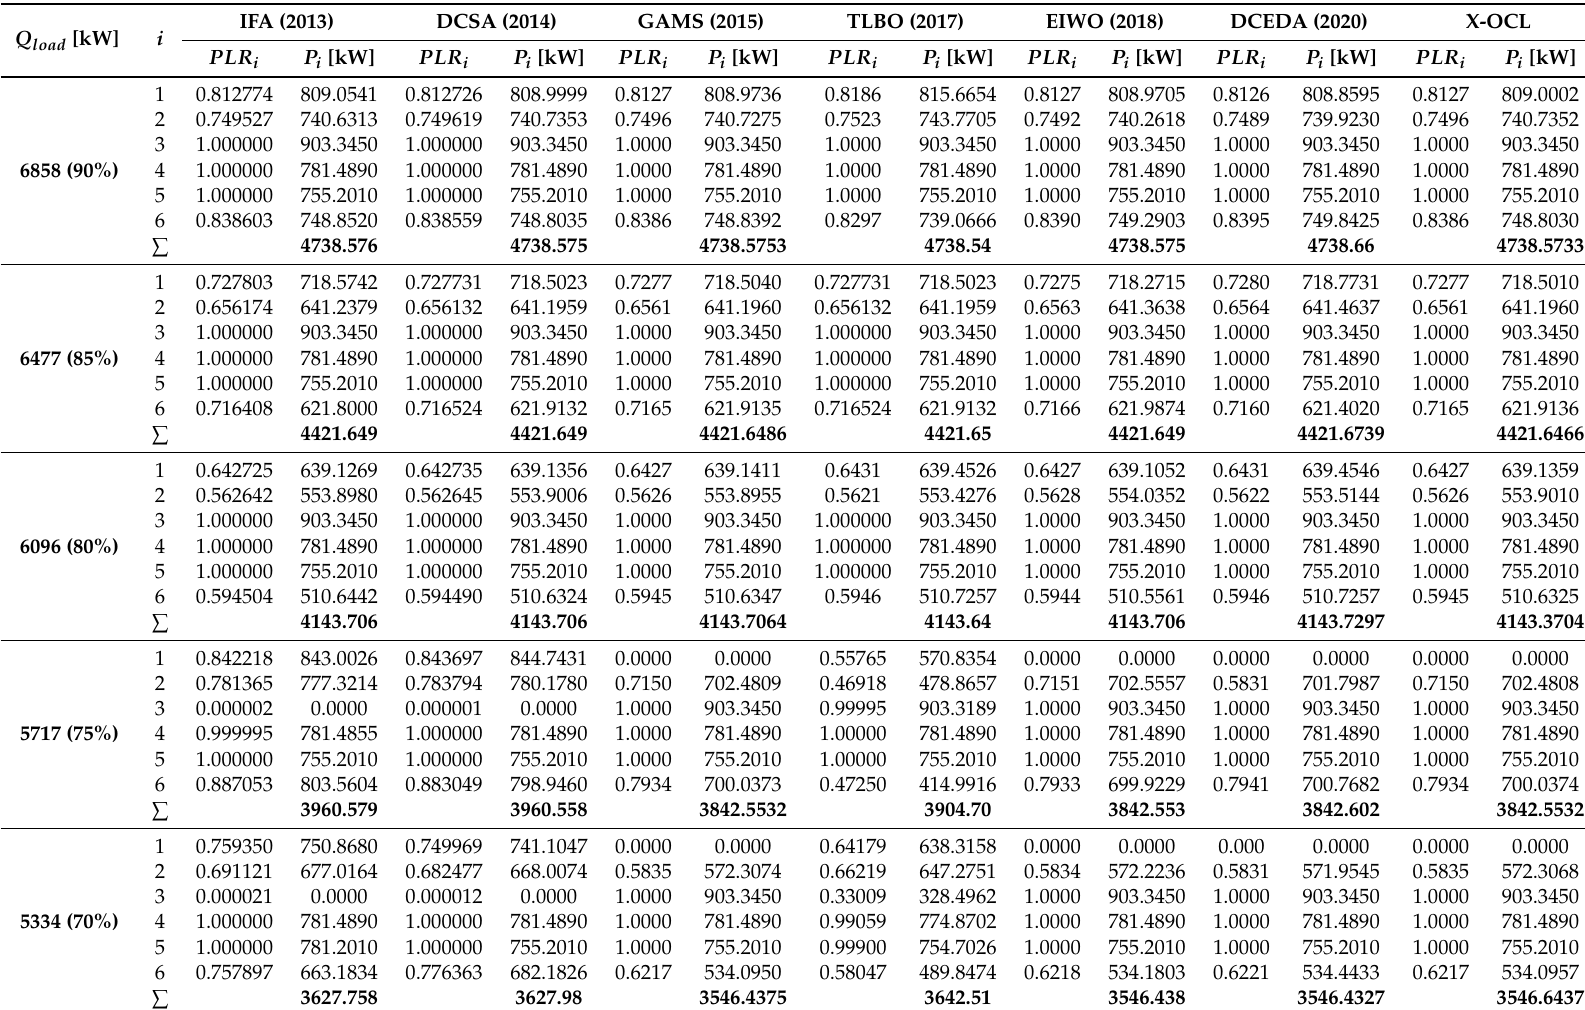
Table 3. Comparison of the results of IFA, DCSA, GAMS, TLBO, EIWO, DCEDA and X-OCL on Hsinchu